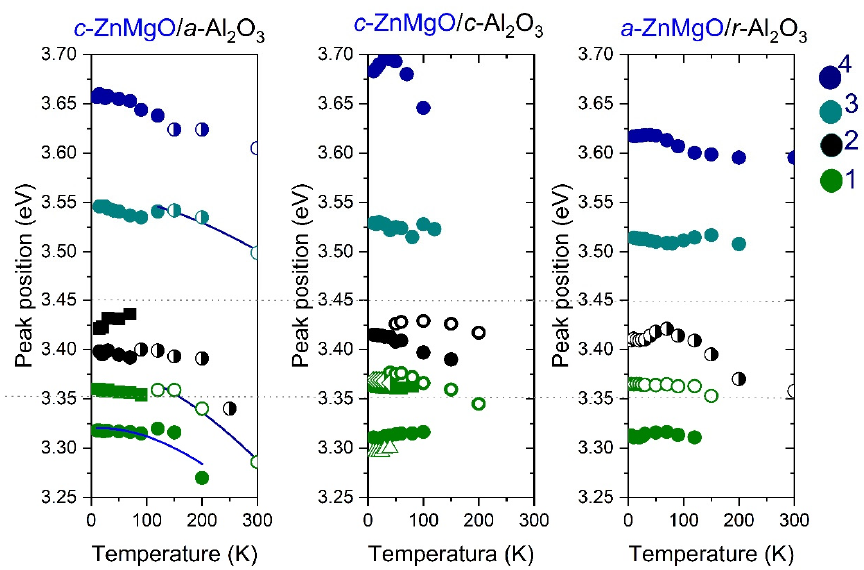
Figure 7. Analysis of the PL peaks position in series of Zn 1 − x Mg x O thin films. The same symbol colors correspond to the position of different PL peaks in the samples with intentionally the same Mg content.